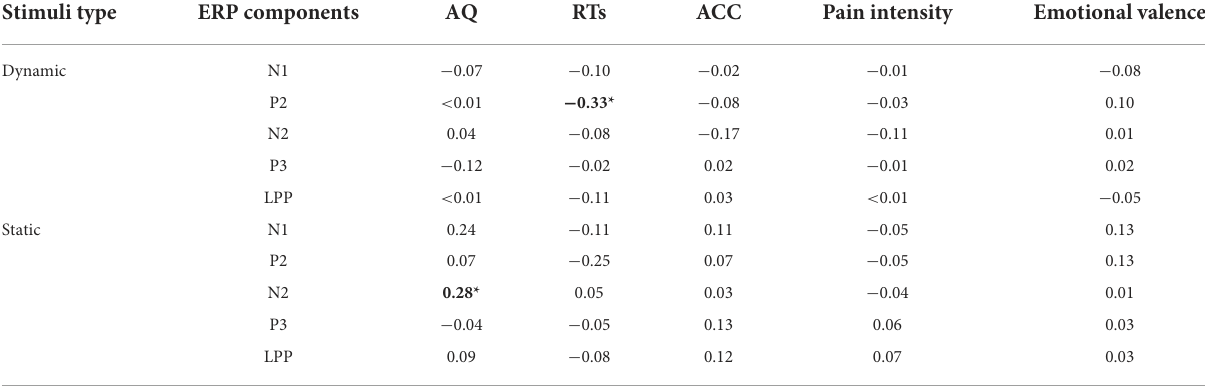
TABLE 4 Correlation between ERP amplitudes and behavioral